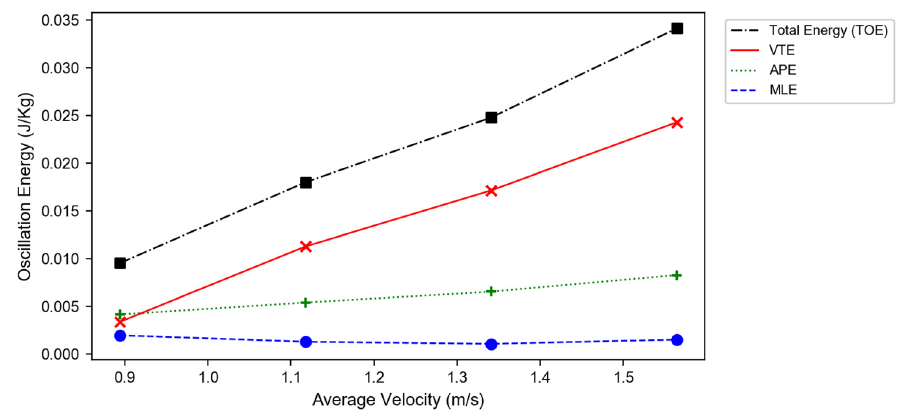
Figure 2. Oscillatory energy versus forward velocity at four walking speeds.